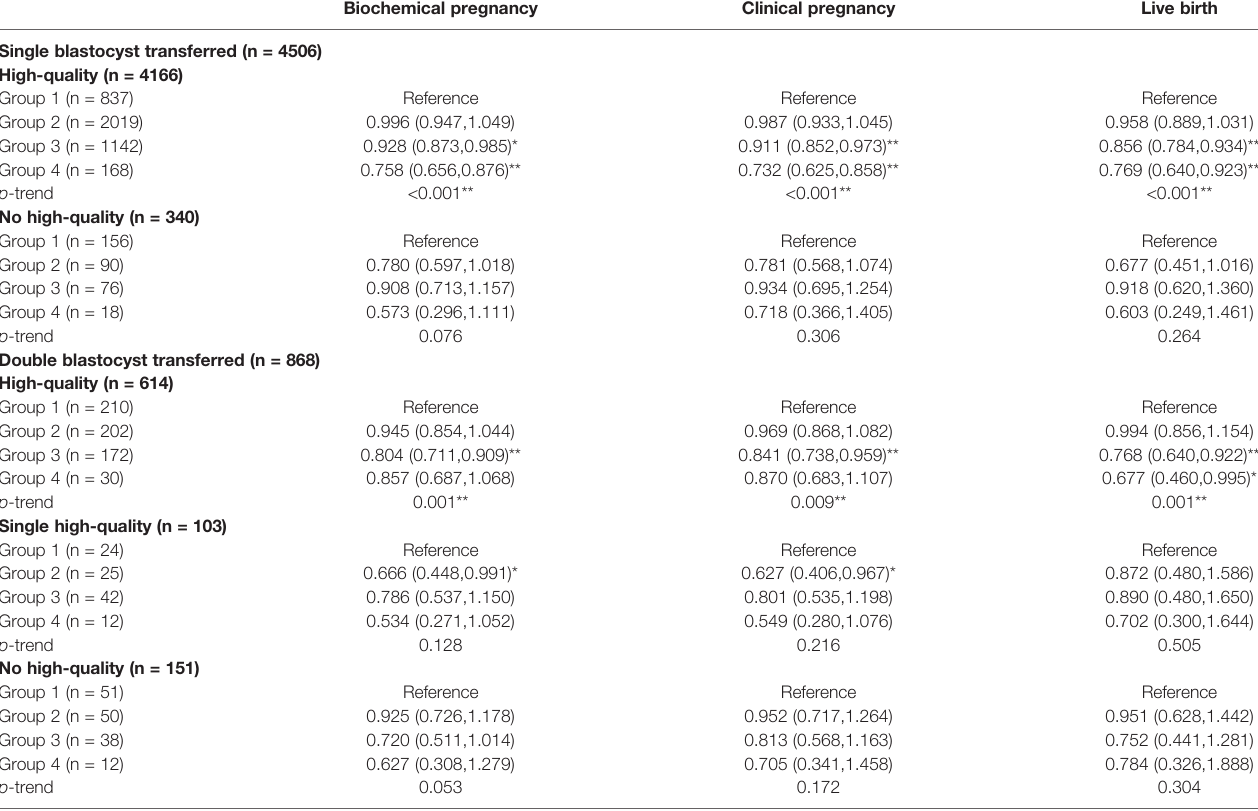
TABLE 4 | The results of strati fi cation analyses assessing the associations between cryopreservation time and pregnancy outcomes based on the number and quality of blastocysts transferred. Biochemical pregnancy Clinical pregnancy Live birth Single blastocyst transferred (n = 4506) High-quality (n =